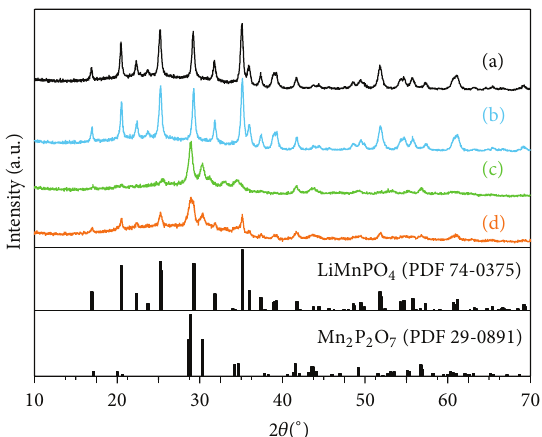
Figure 1: XRD pattern for LiMnPO 4 using various precursors: (a) sample A, (b) sample B, (c) sample C, and (d) sample D.